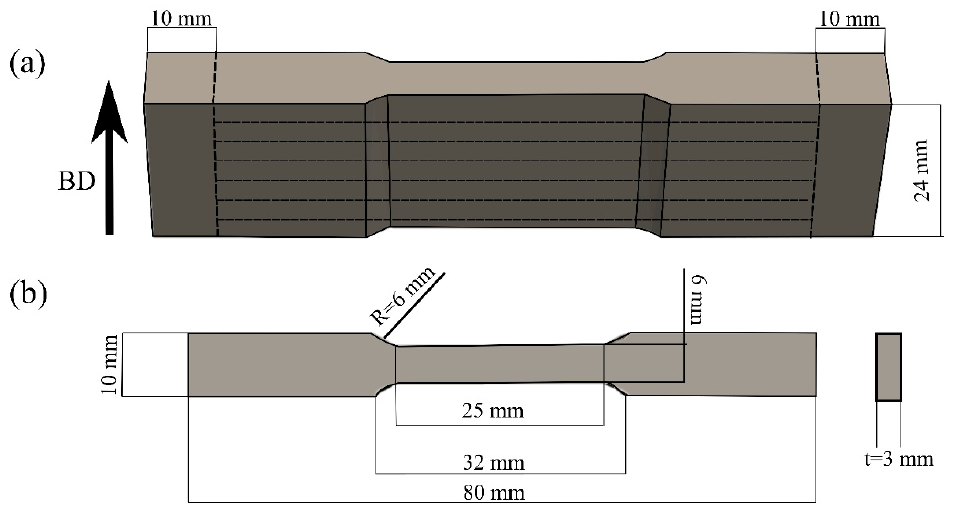
Figure 2. ( a ) Geometry of coupons fabricated by in envelope additive (LPBF)/subtractive manufac- turing showing the outlines for extracting the metallographic sections and tensile specimens, and ( b ) standard sub-size tensile specimen geometry according to ASTM E8M-22 [28]. Metallographic sections (10 × 10 × 24 mm 3 ) and tensile specimens were then extracted from each of the four coupons, as shown in Figure 2a. The metallographic sections were used to extract representative specimens for heat treatment, density measurement, X-ray micro-CT inspection, microstructural analysis, phase analysis by X-ray diffraction, and microhardness testing. By contrast, the extracted tensile specimens (3 mm-thick) were used for tensile testing and conformed to the standard sub-size geometry in ASTM E8M-22 [28] with a gauge length of 25 mm and width of 6 mm as shown in Figure